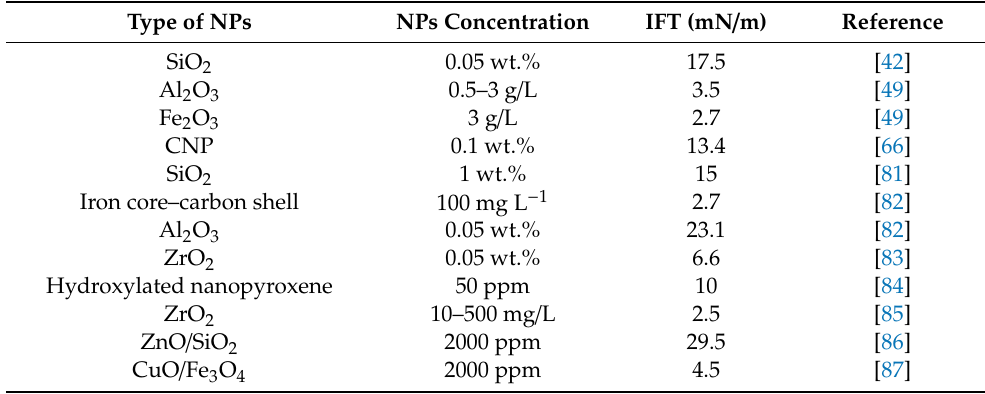
Table 2. E ff ect of nanoparticles on